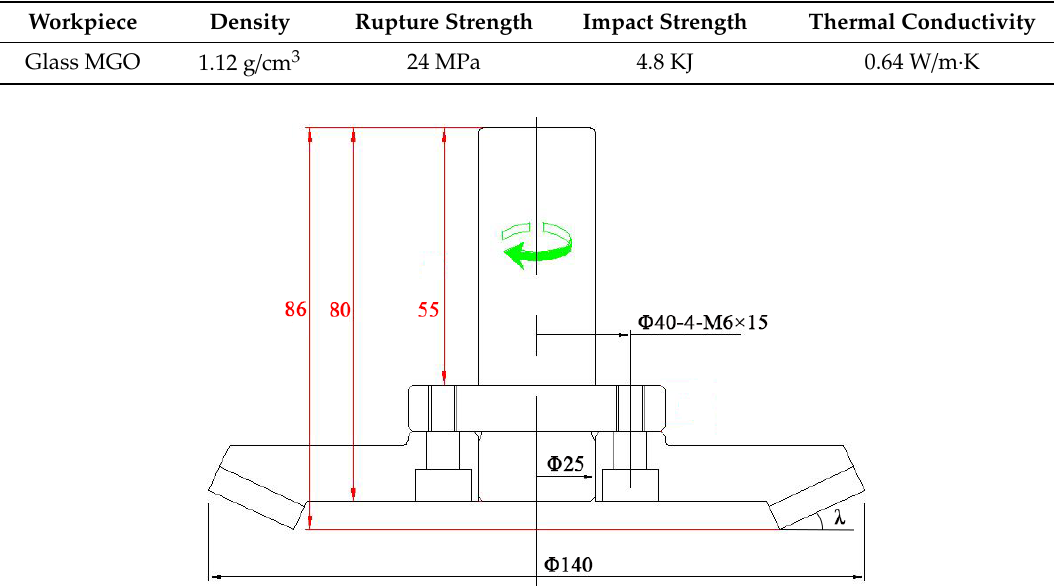
Figure 1. Tapered cutter used in this work (mm).